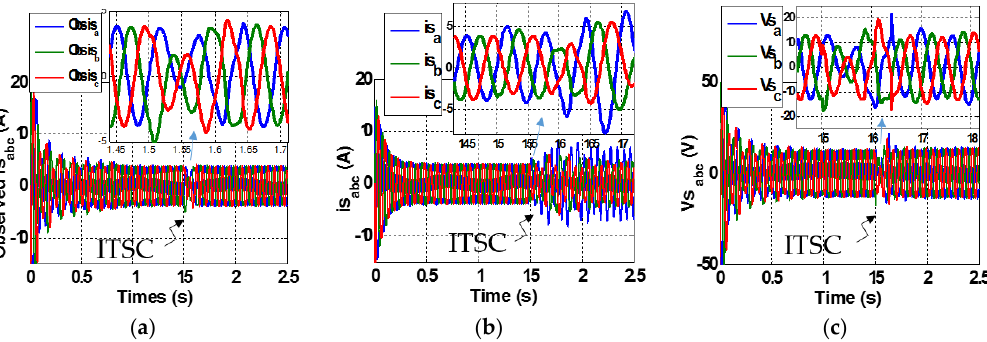
ˆ s s i ; ( b ) measured abc ; ( b ) measured abc